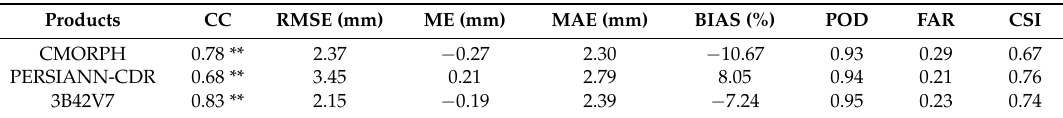
Table 3. Summary of statistical metrics for the three satellite precipitation products. The metrics were calculated based on basin-averaged precipitation. Products CC RMSE (mm) ME (mm) MAE (mm) BIAS (%) POD FAR CSI